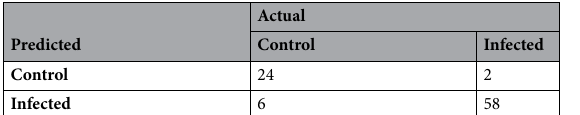
Table 3. Classification of infected and uninfected urine samples achieved using PC-LDA on the acquired Raman spectra. Accuracy 91.1% (CI: 83.2–96.0%; p-value < 0.05), Cohen’s K = 0.79. Sensitivity 97%, Specificity 80%.